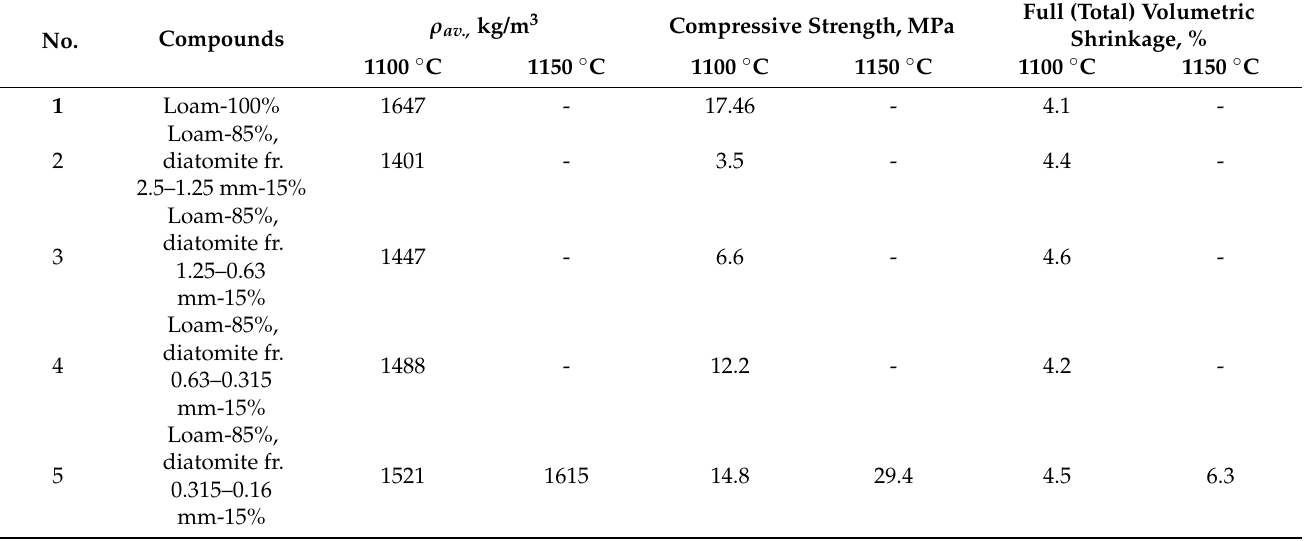
Table 2. The influence of the fractional diatomite compound and firing temperature on the properties of the